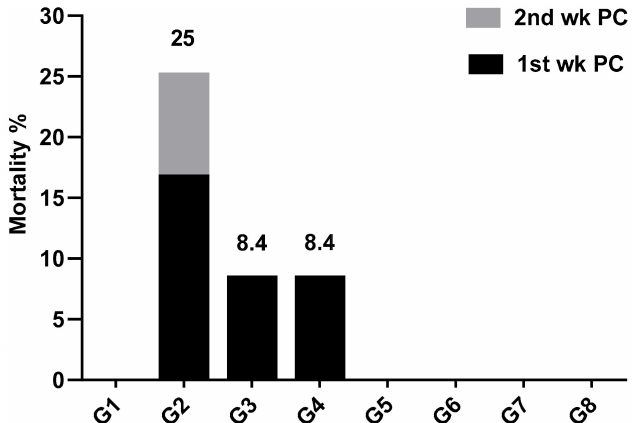
Figure 1. Mortality percentage during two weeks post challenge (PC) with Salmonella Enteritidis (SE). wk—week;